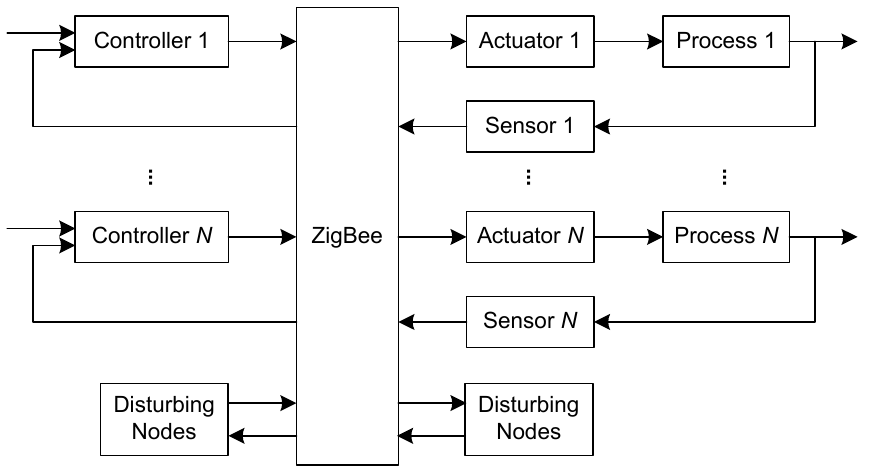
Figure 2. Block diagram of the wireless control